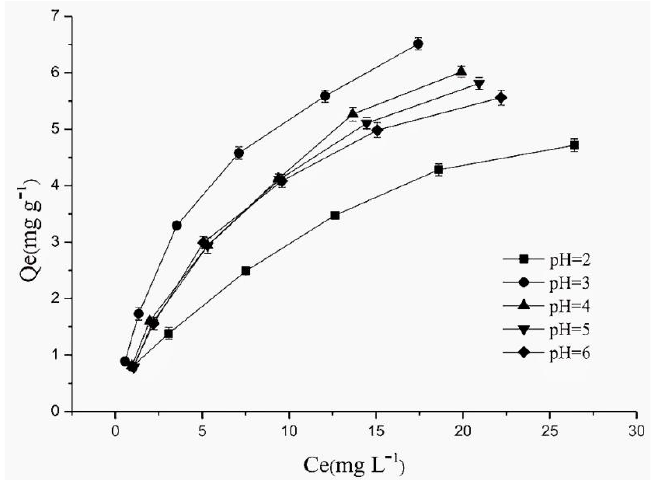
Figure 19. Effect of pH on adsorption of As(III) by FMBC [58]. Reprinted with permission from Lina Lin et al. (2017). Copyright 2017, Elsevier.